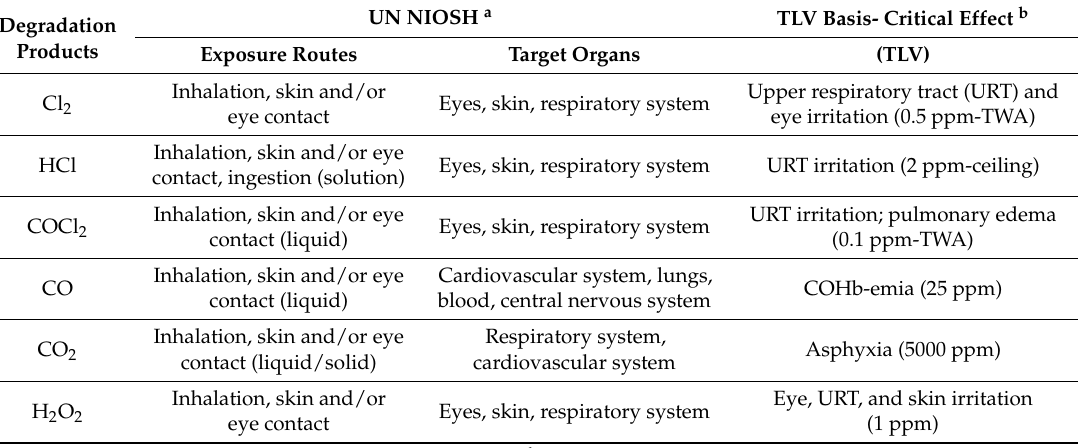
Table 6. Hazards of degradation products of chloromethanes to human